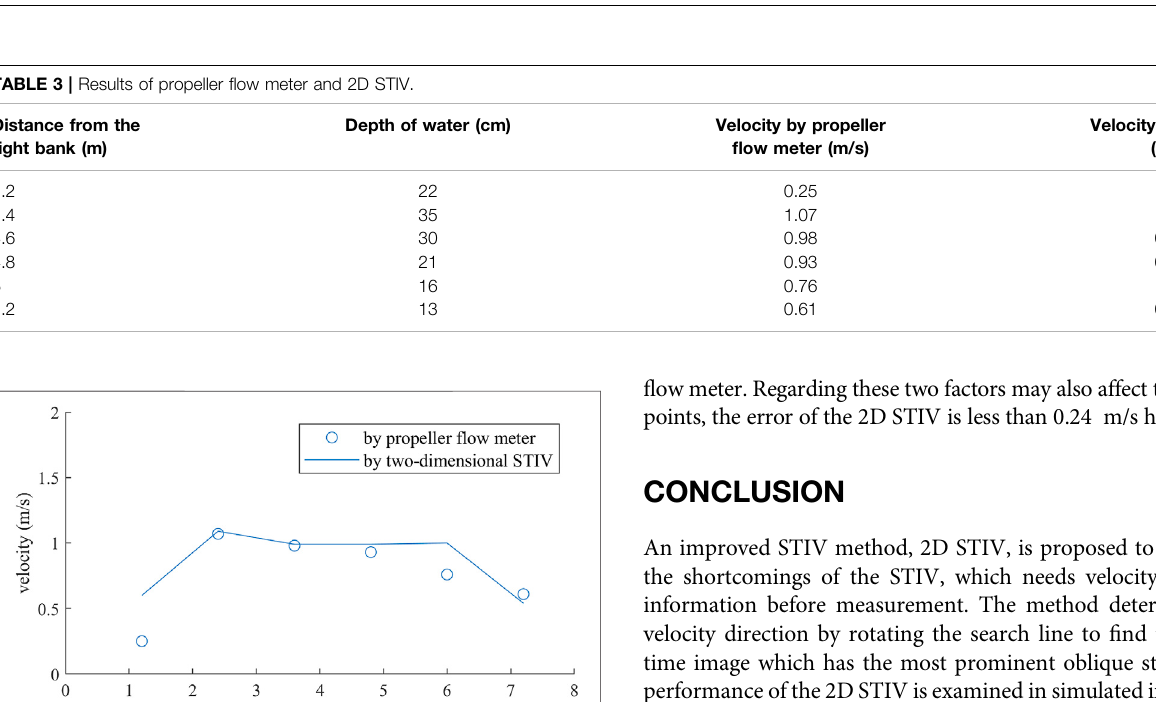
FIGURE 11 | Comparison of the results by propeller fl ow meter and 2D